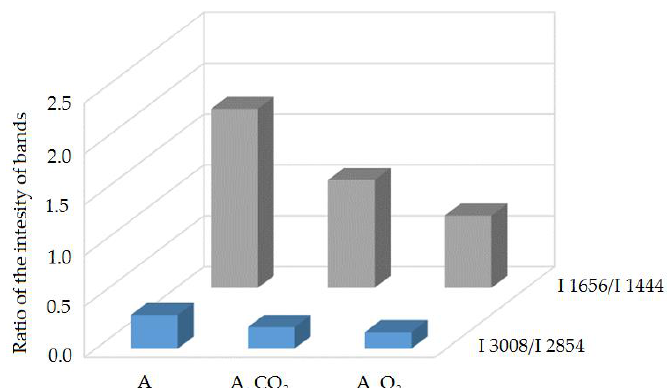
Figure 2. The influence of the modification process on the change in the unsaturation degree of fatty acids in the researched oils: A, A_CO 2 and A_O 2 , expressed by I 1656 /I 1444 and I 3008 /I 2854 bands intensity ratio.